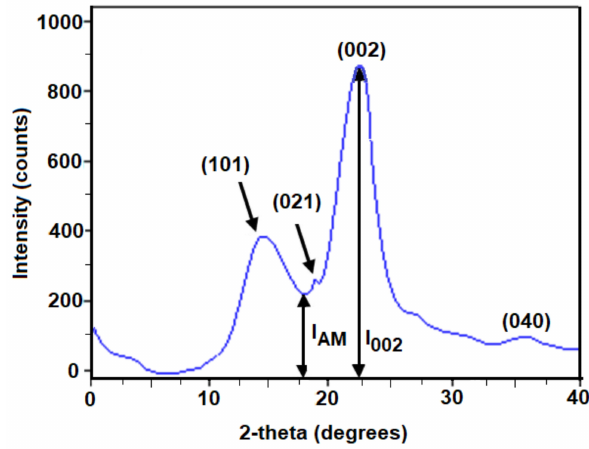
Figure 5. X-ray diffraction (XRD) spectrum for